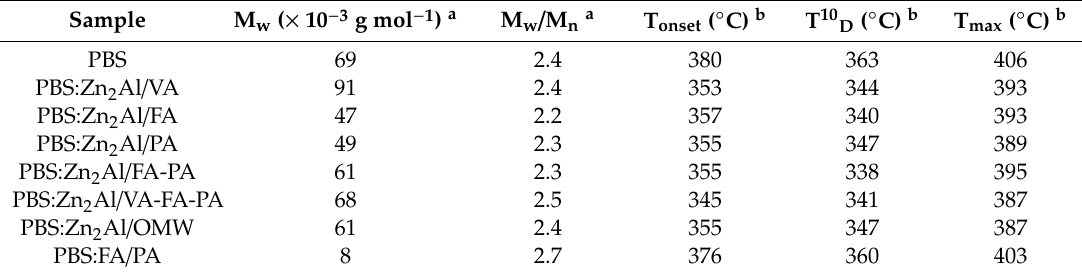
Table 1. Gel permeation chromatography (GPC) and thermogravimetric analysis (TGA) results of PBS,